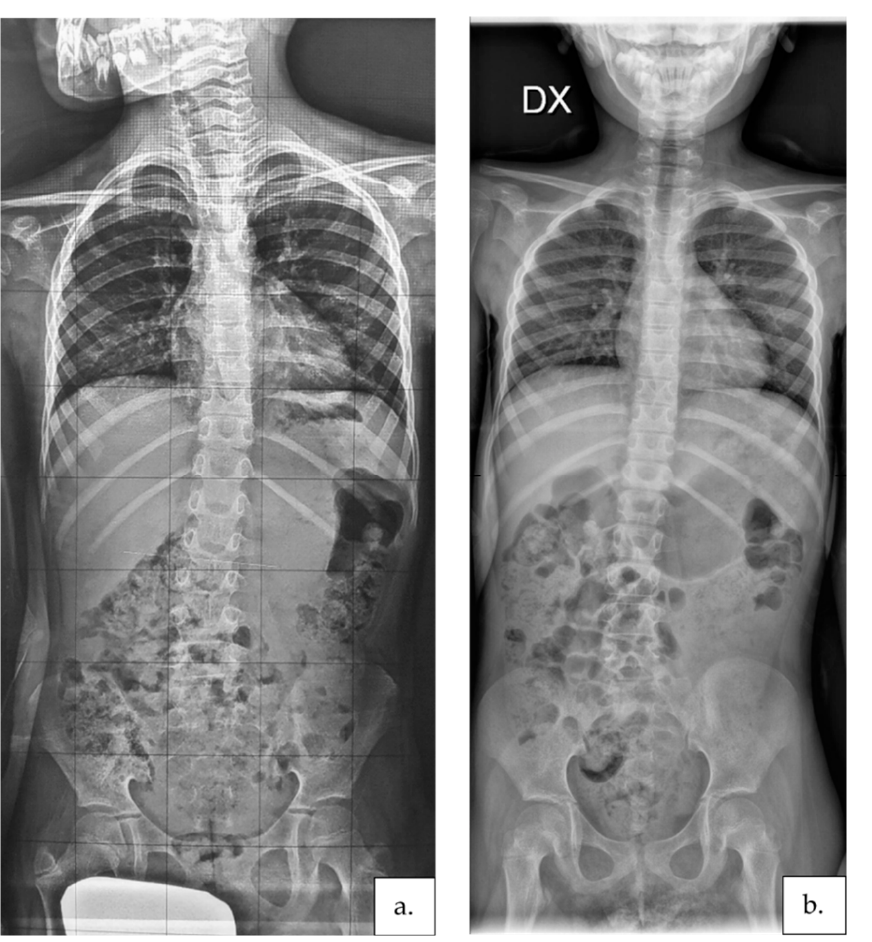
Figure 3. Participant no. 8 (cid:48) s X-rays collected before ( a ) and after ( b ) the intervention. She was 6.5 years old at T1. At baseline, she could walk for more than 10 steps supported by one hand and independently stand for 30 s. Lack of efficient balance reaction was recognized at T1. Therefore, her program included intensive balance training and asymmetrical posture maintenance. At the end of the intervention, she could walk for more than 10 steps and stand for more than one minute independently. An improvement of 10 ◦ Cobb was recognized at